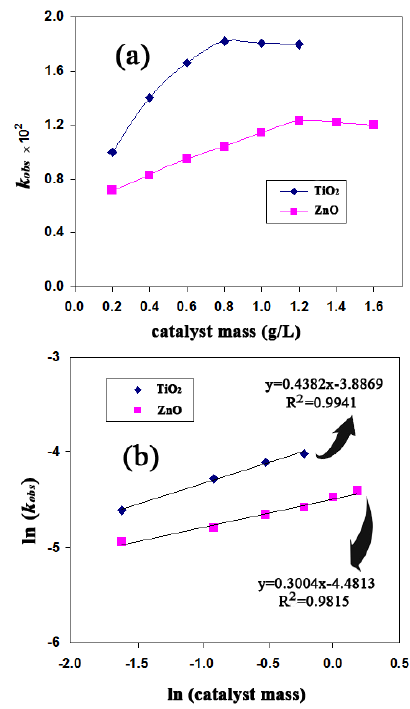
Figure 2. E ff ects of the amount of catalyst (TiO 2 or ZnO) on ( a ) heterogeneous photocatalytic oxidation (HPO) rate constant and ( b ) relationship between ln( k obs ) and ln(catalyst mass); [FB1] 0 = 50 mg / L, T = 25 ◦ C and pH = 6.7. FB1, Food Black